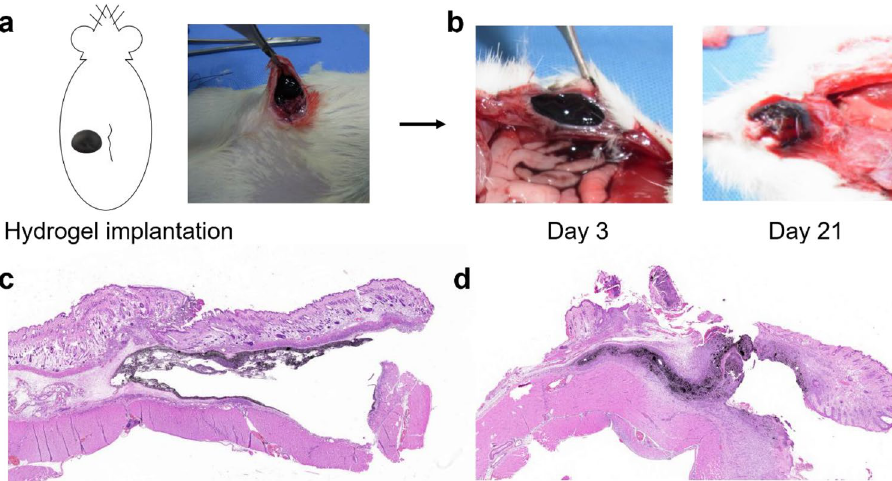
Figure 7. In vivo rat experiments for hydrogel implantations. ( a ) Experimental procedures for hydrogel implantations. ( b ) Photos of hydrogels on the rat abdominal wall after 3 (left) and 21 days (right). ( c,d ) Histological analysis of H/E stained rat intestine after 7 ( c ) and 14 days ( d